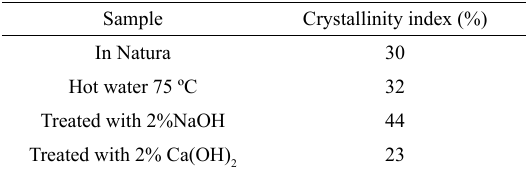
Table 4. Crystallinity index of piassava fibers "in natura" and after surface